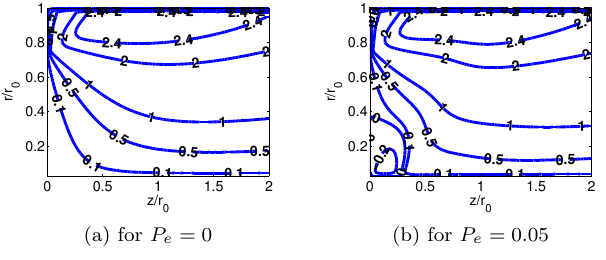
Figure 4. Levels of radial